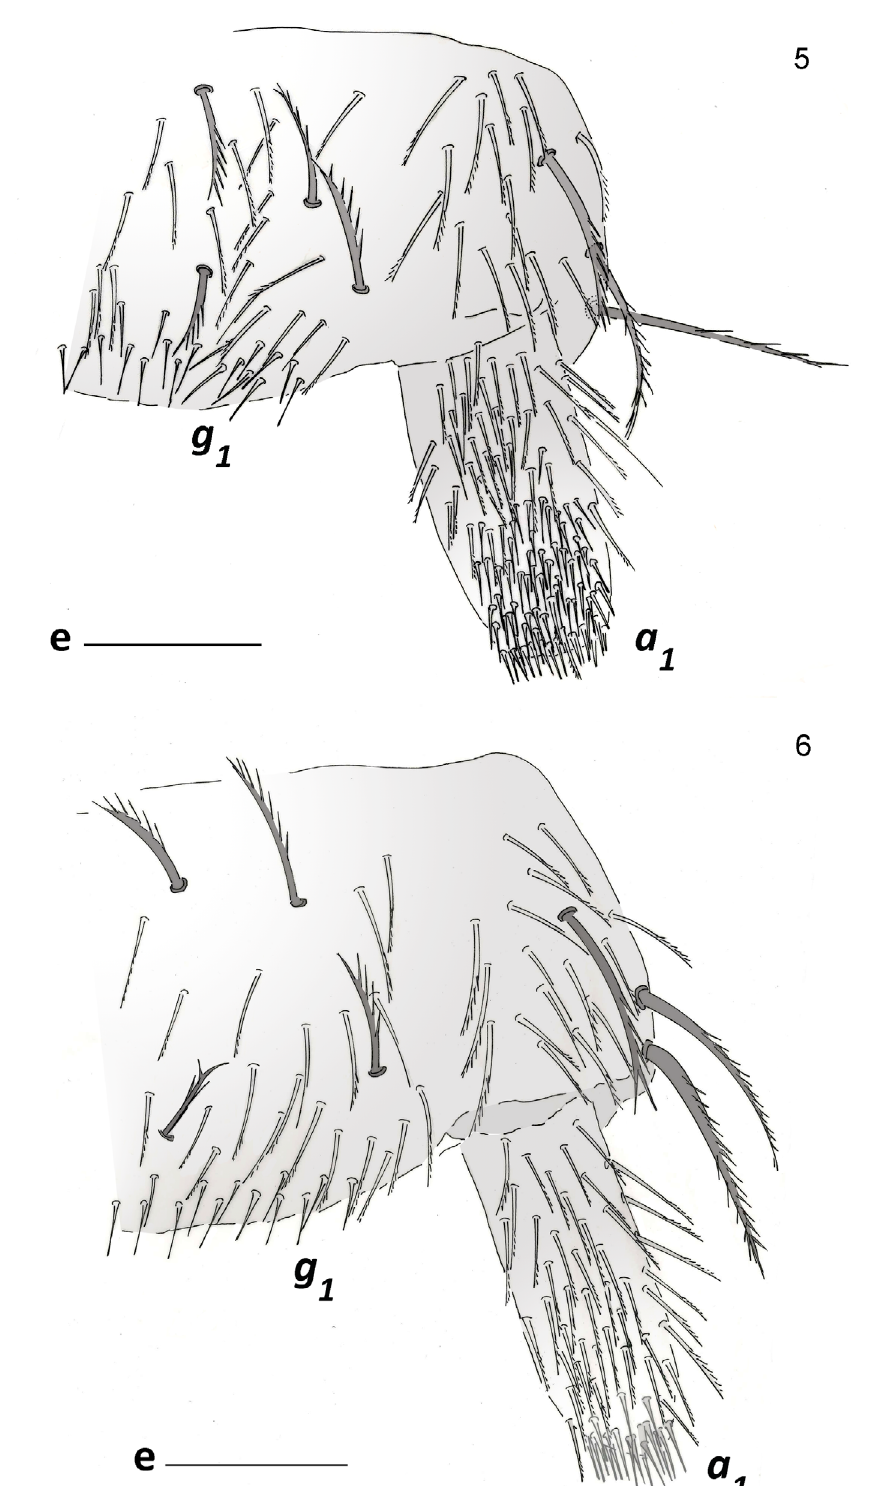
Figs 5–6. Plusiocampa (Pentachaetocampa) inopinata subgen. et sp. nov. Urosternite I. 5 . Male. 6 . Female. a = a -glandular setae, g 1 1